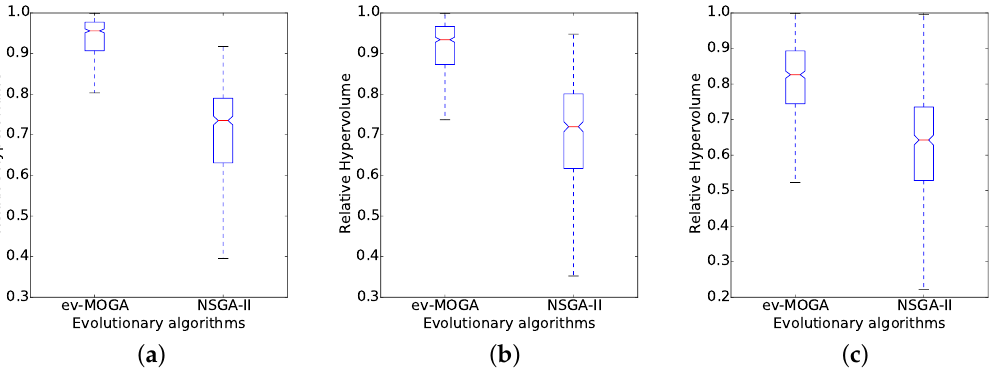
Figure 6. Relative hypervolume computed by Epsilon-Variable Multi-Objective Genetic Algorithm (ev-MOGA) and Non-dominated Sorting Genetic Algorithm version II (NSGA-II) for each workload size. ( a ) small workload size; ( b ) medium workload size; and ( c ) large workload size.